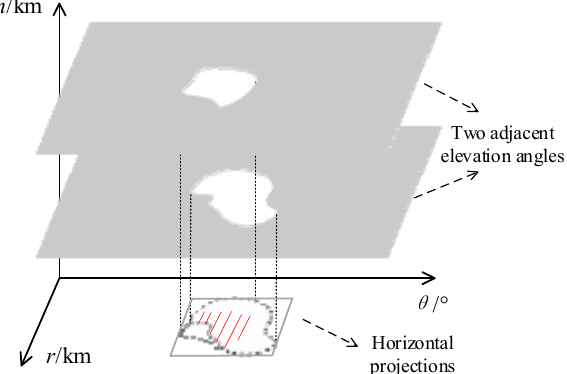
Figure 5. Determination of the rectangular recognition area, where h is the height from the ground. The high reflectivity regions at different elevation angles are projected horizontally. If the overlapping area of two projection areas at different elevation angles is larger than 60% of the smaller projection area, the two regions are considered to be located in the same airflow field. The minimum bounding rectangle, which we set as a(°) × b(km), of correlated high reflectivity regions’ projections at all elevation angles is taken to determine the position of the airflow field and as the recognition area.